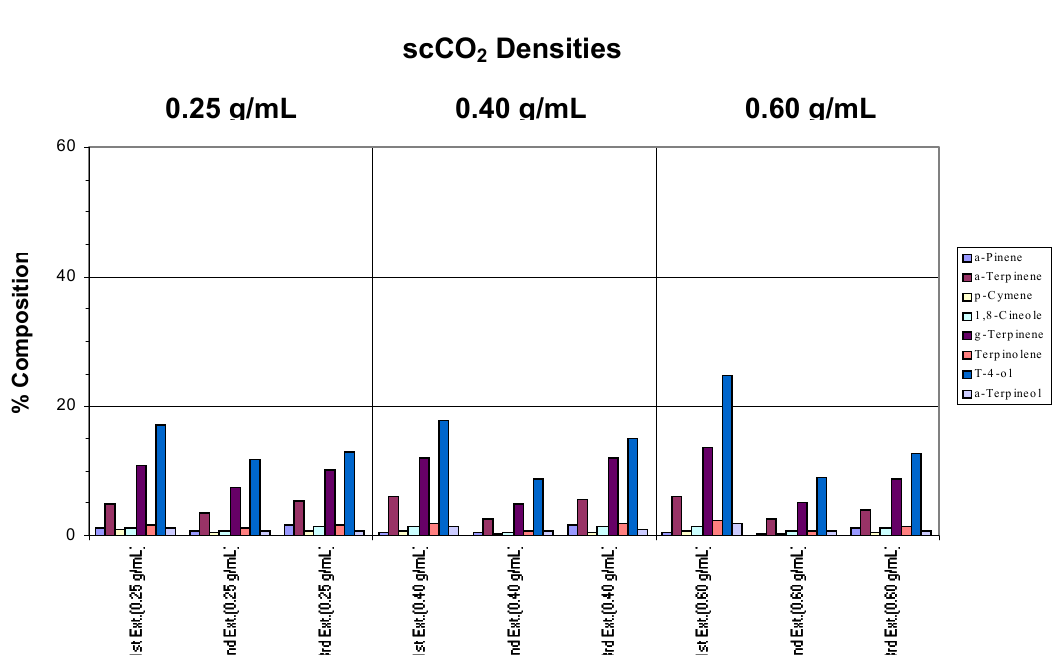
Figure 3. Recovery of target analytes from whole dried leaves using a chamber temperature of 110 o